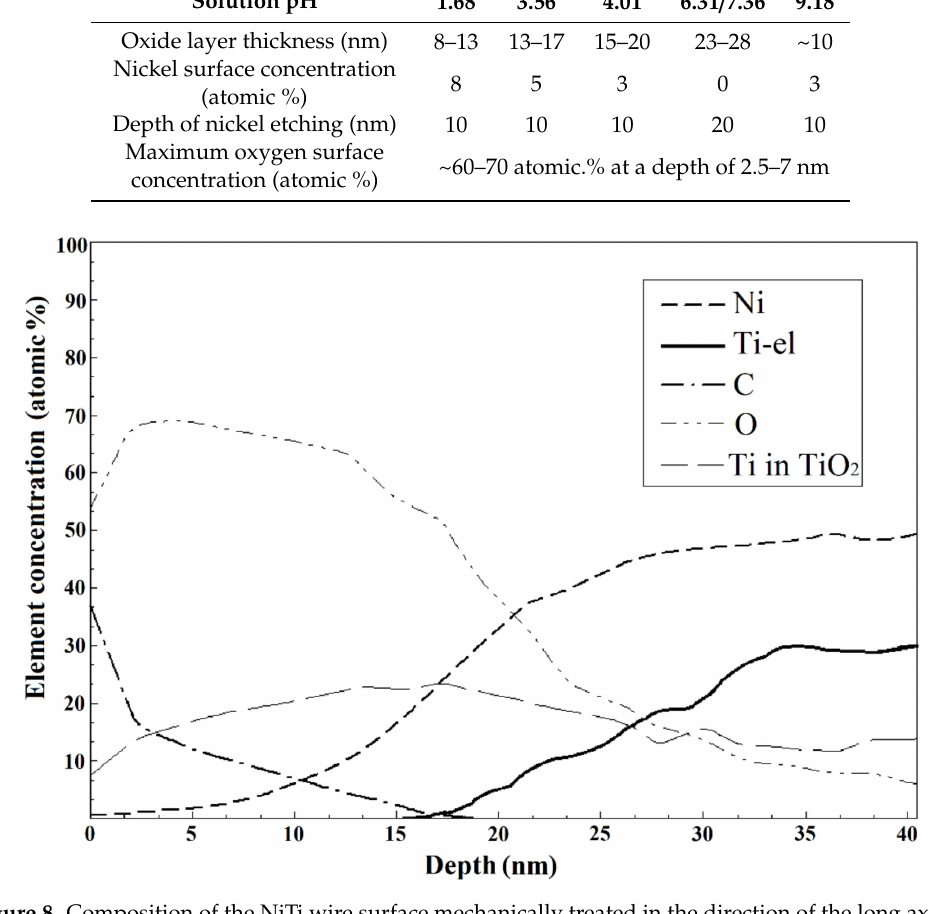
Figure 8. Composition of the NiTi wire surface mechanically treated in the direction of the long axis of the samples using diamond paste (3 µ m followed by 1 µ m) after immersion for two years in 0.9 wt % NaCl (Solution 4, Table 1), as determined by Auger spectroscopy. “Ti in TiO 2 ” and “Ti-el” mean bonded and elemental forms of Ti,